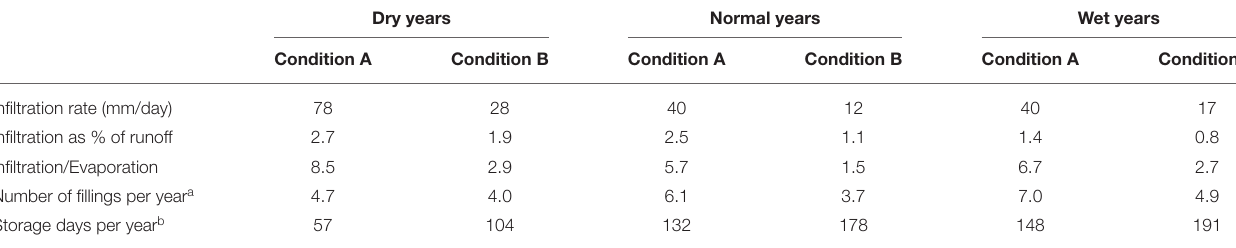
TABLE 3 | Check dam’s performance indicators for different rainfall